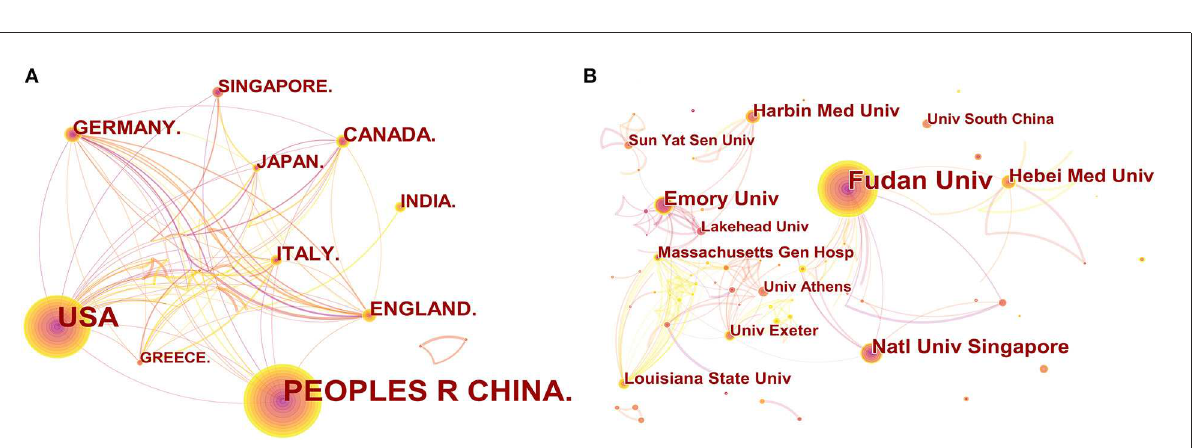
FIGURE2 CiteSpace network visualization map of country/regions and institutions involved in hydrogen sulfide in heart preservation research. (A) Collaboration analysis of countries/regions. Of the 54 countries/ regions, 10 had at least 10 publications. (B) Collaboration analysis of institutions. Of the 272 institutions, 5 had at least 10